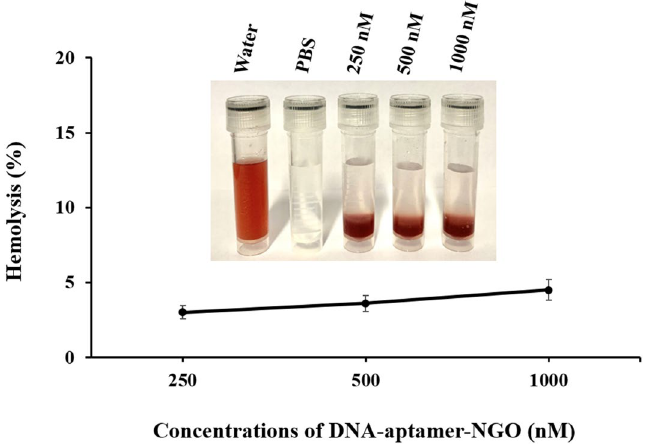
Figure 7. Hemolysis assay of human red blood cells exposed to DNA-aptamer-NGO at the different concentrations (250, 500, and 1000 nM) at a 37 °C water bath for 1 h. The absorbance was analyzed by a UV–Vis spectrophotometer at 540 nm. Distilled water and PBS solution were used as the positive and negative control, respectively.